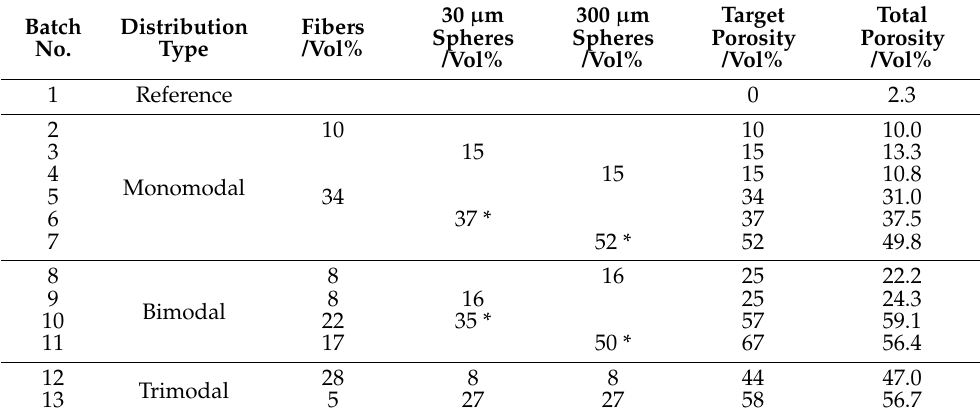
Table 1. Compositions and corresponding target and total porosities of the realized alumina ceramics with monomodal, bimodal, and trimodal mixtures of sacrificial templates. Batch No.